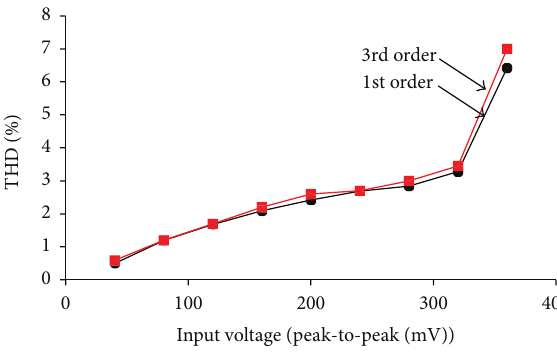
Figure 9: THD variation of 1st and 3rd order